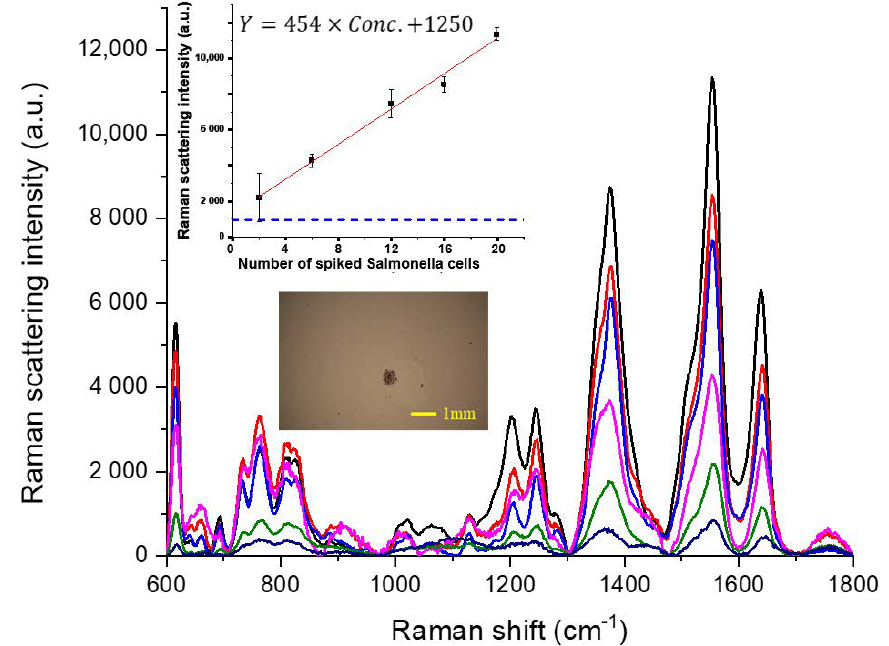
Figure 4. SERS spectra of Safranin O-labelled NAEBs acquired from the dried spots of tag-bound Salmonella cells from spiked samples of 100 g ice cubes. From the top of main frame, the spectral traces in black, red, blue, pink, and green are from the spiked samples containing 20, 16, 12, 6, and 2 Salmonella cells, respectively. The bottom trace in green is from the negative control sample containing only NAEB tags in the absence of Salmonella